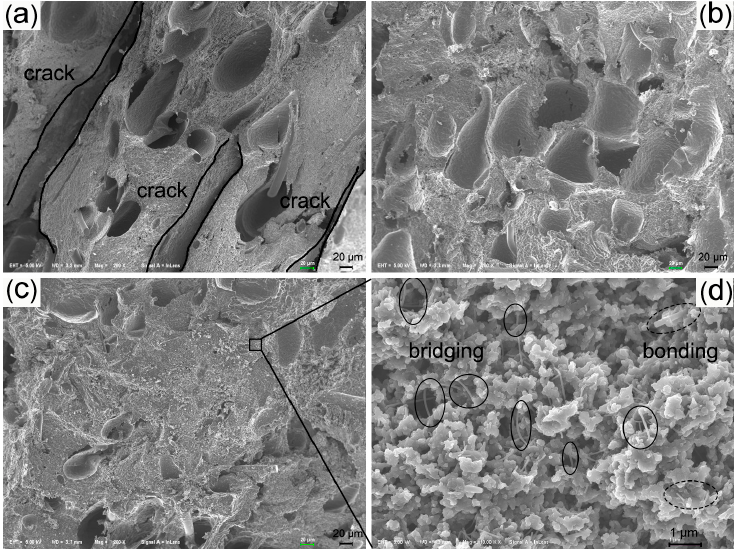
Figure 9. Cross section morphologies of char layer of SR composites after oxyacetylene torch